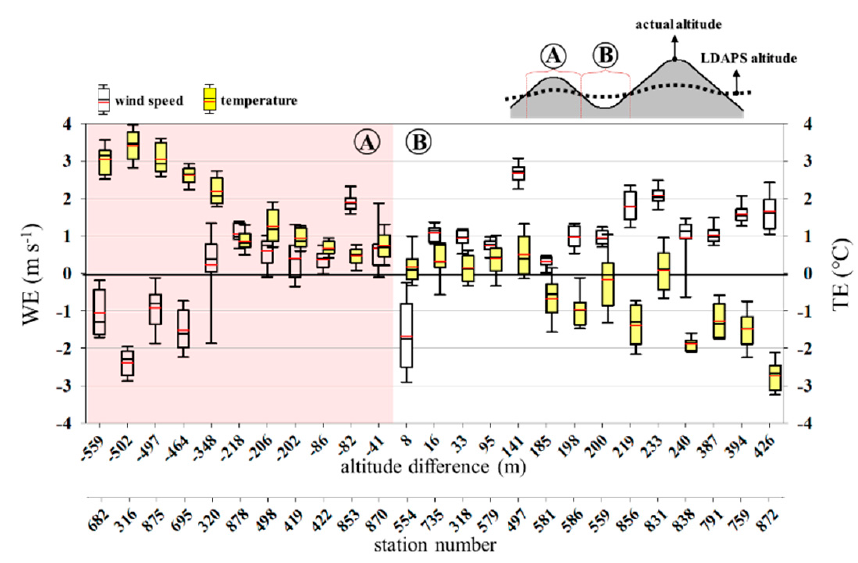
Figure 8. Box plots of the WEs and TEs at the Rm AWSs. Left panel shaded in pink represents the cases that the LDAPS altitudes are higher than the actual altitudes ( ○ A ). Right panel shaded in blue indicates the opposite cases ( ○ B ).